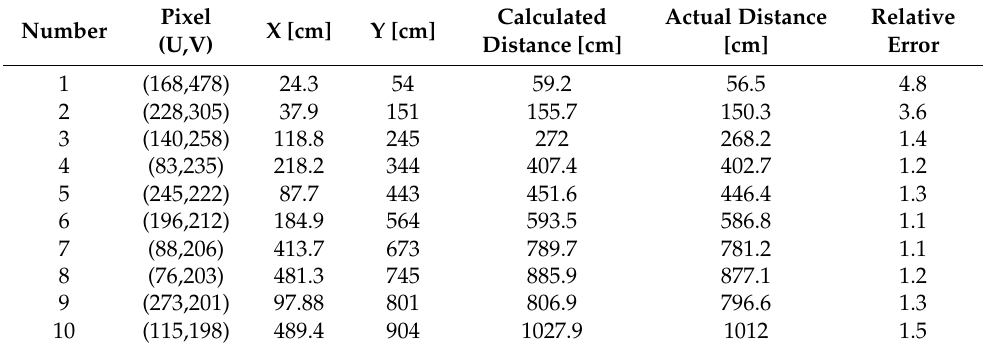
Figure 4. Mimic diagram of parallel parking spot. Table 1. Performance comparison with other state-of-the-art methods on the various datasets.